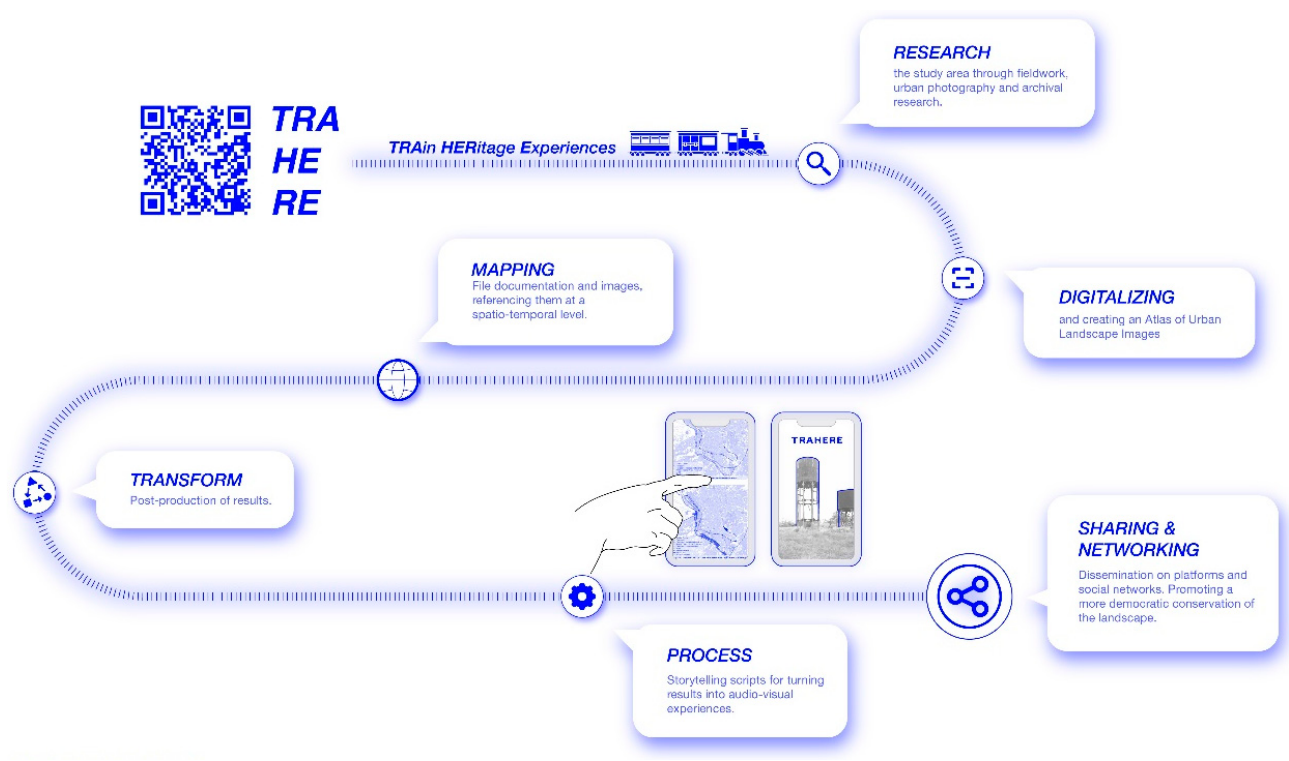
Figure 2. Initial objectives. Source: TRAHERE’s own elaboration.